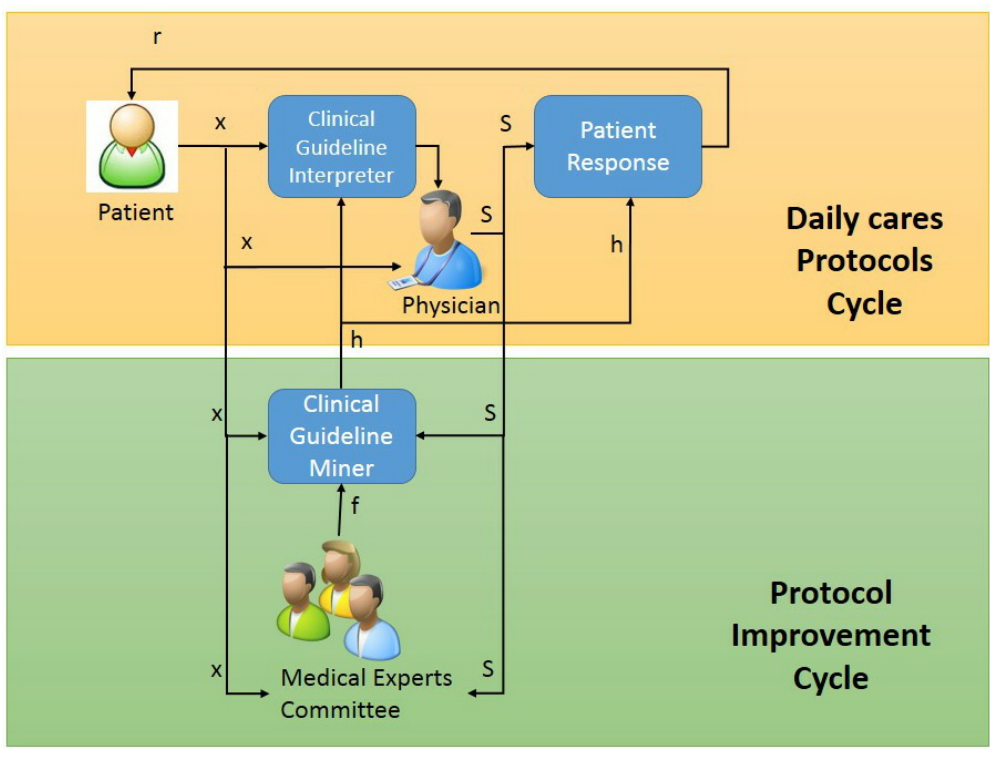
Figure 1. Proposed dual interactive